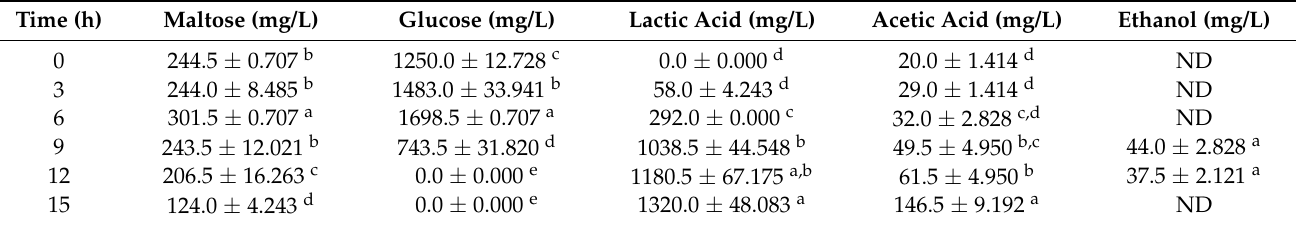
Table 8. Results of sugar, organic acid, and ethanol in mixed-strain fermentation of ETF substrate.